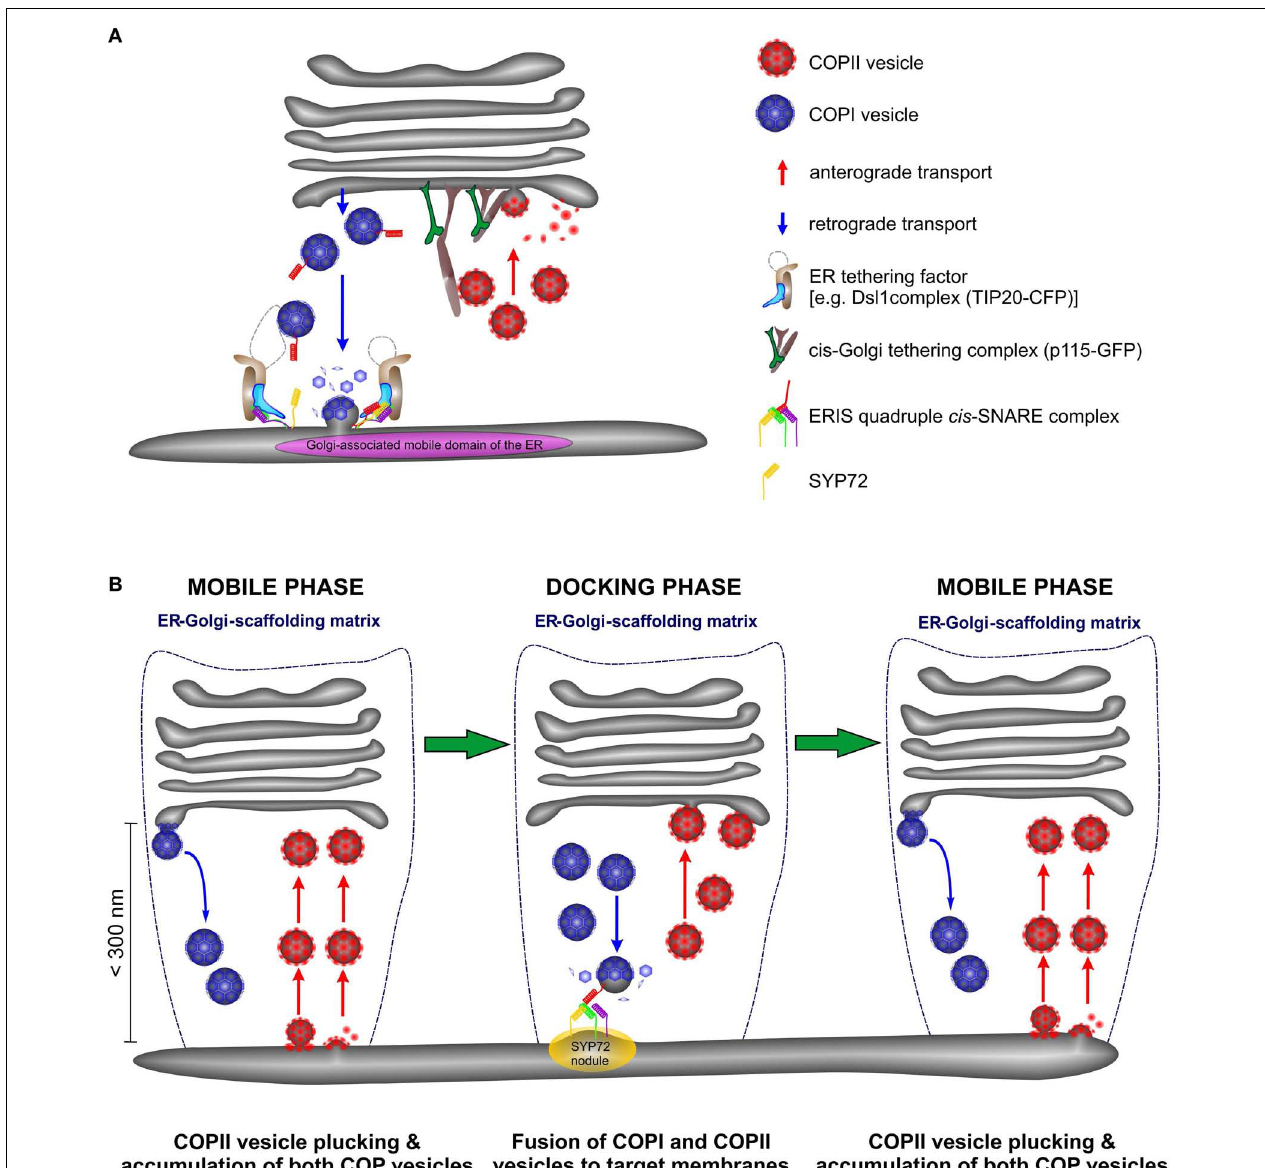
tethering factors (dotted blue line). As Golgi stacks move they capture individual COPII vesicles released from ERES at the surface of the ER (“mobile phase”) and release COPI vesicles. Both types of vesicles accumulate in the ER-Golgi interface.When the Golgi stacks temporarily stop moving (“docking phase”) fusion of COPI and COPII vesicles to their respective target membranes occurs. Golgi stacks stop at ERIS as marked by the presence of “SYP72 nodules” on the